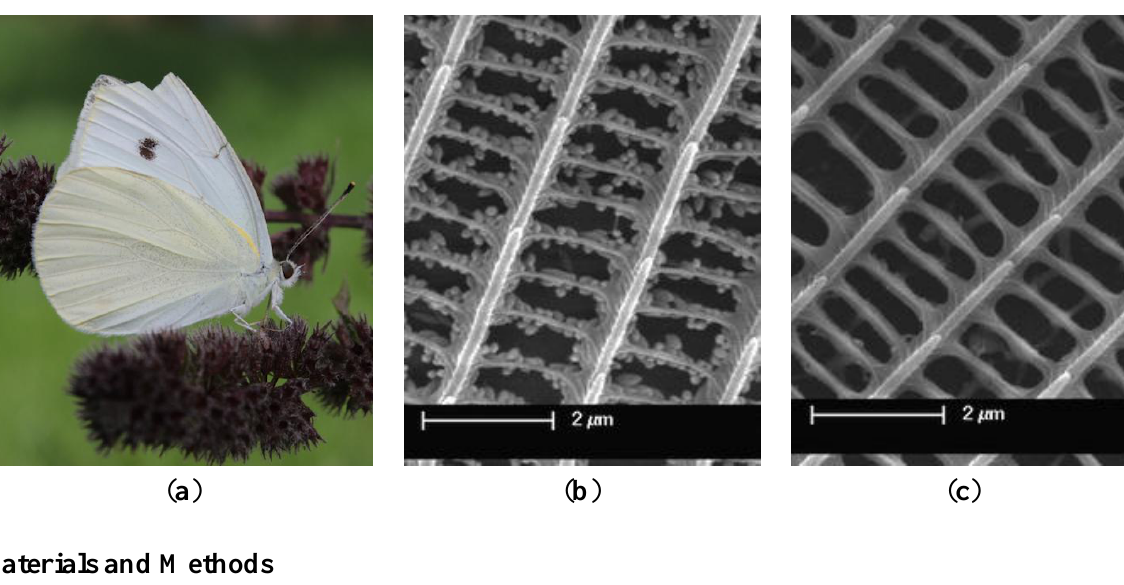
Figure 1. ( a ) Pieris rapae butterfly with white wings and black spots; ( b ) SEM pictures of Pieris rapae butterfly microstructure showing white areas of the wings that correspond to the areas populated with beads; ( c ) SEM pictures of Pieris rapae butterfly microstructure showing black areas of the wings that correspond to the areas where beads are